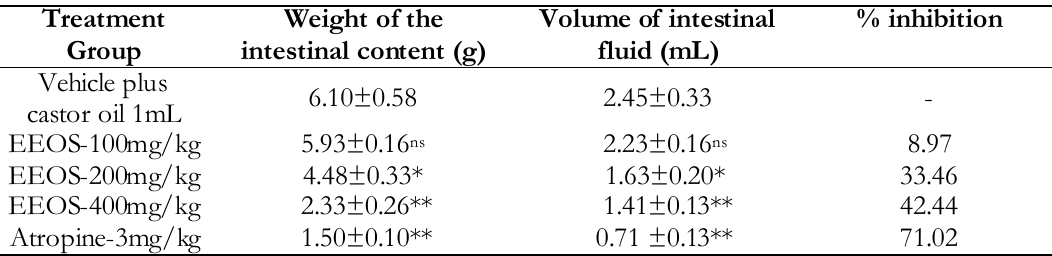
Table V: Effect of EEOS on castor oil induced enteropooling